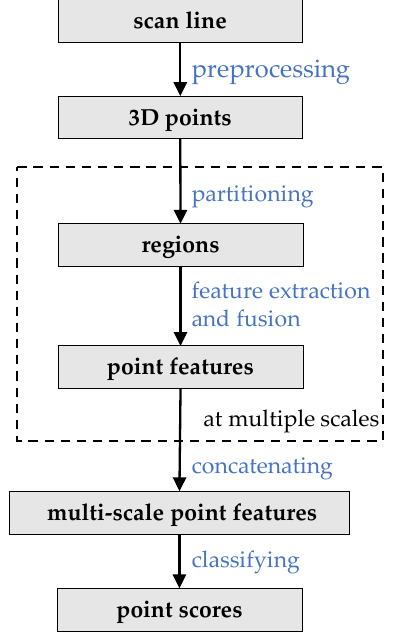
Figure 2. Data processing framework. Points are classified scan line by scan line. Firstly, data of a scan line are transformed into a 3D coordinate system. Secondly, point features with 3D contexts are extracted at multiple scales by the iterative point partitioning algorithm and the SFN. Finally, the multi-scale local features are concatenated together and then input to a classifier to yield point